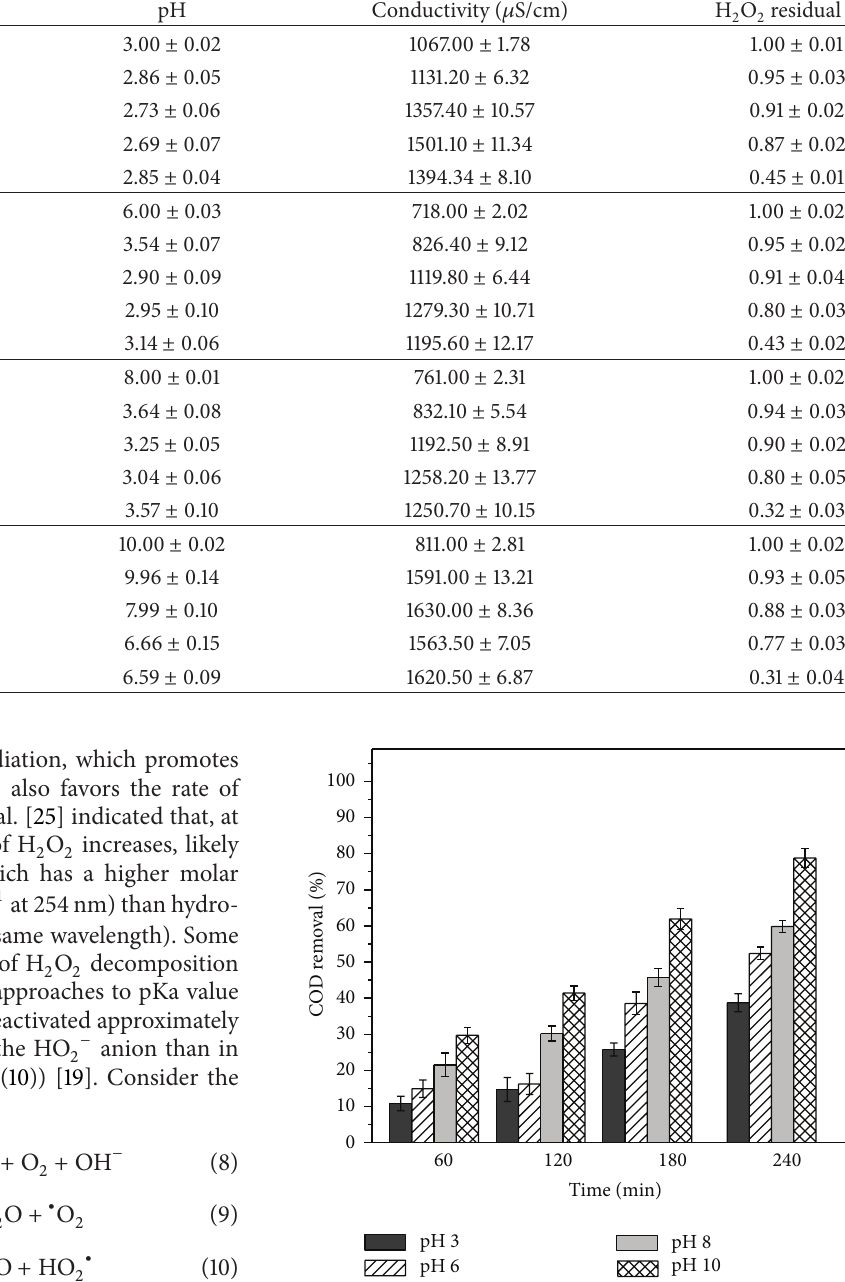
Table 2: Effect of the irradiation time and pH in some physical-chemical parameters. Experimental conditions: UV/1% H Initial pH